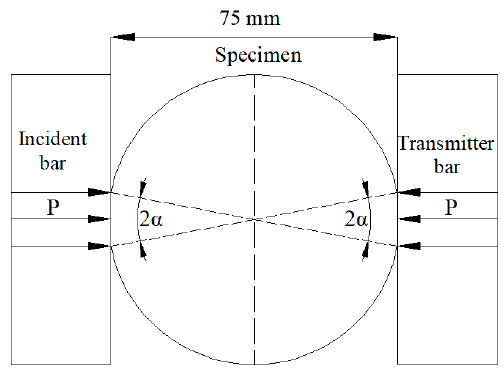
Figure 3. The flattened BD specimen in the SHPB test.